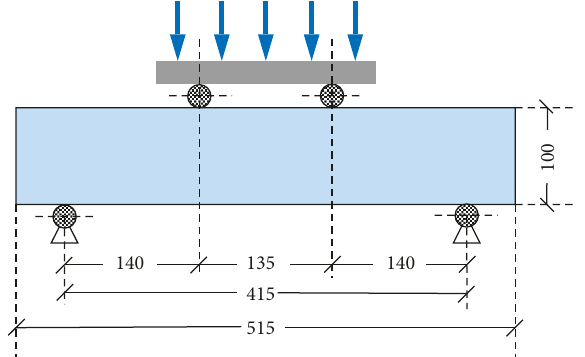
Figure 3: Specimen dimensions and loading manner of the flexural